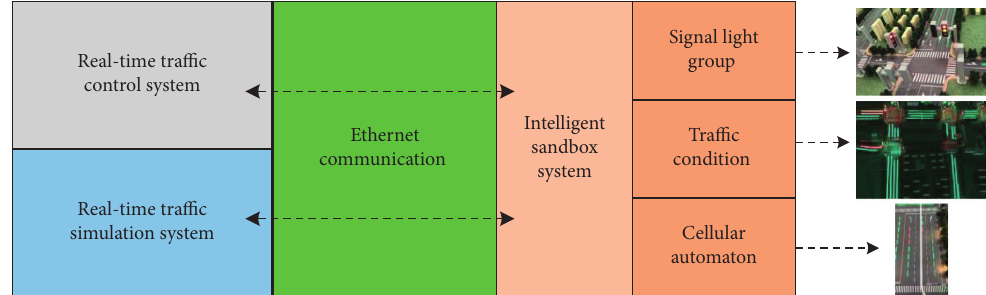
Figure 7: Visualized hardware and software in the loop system architecture.